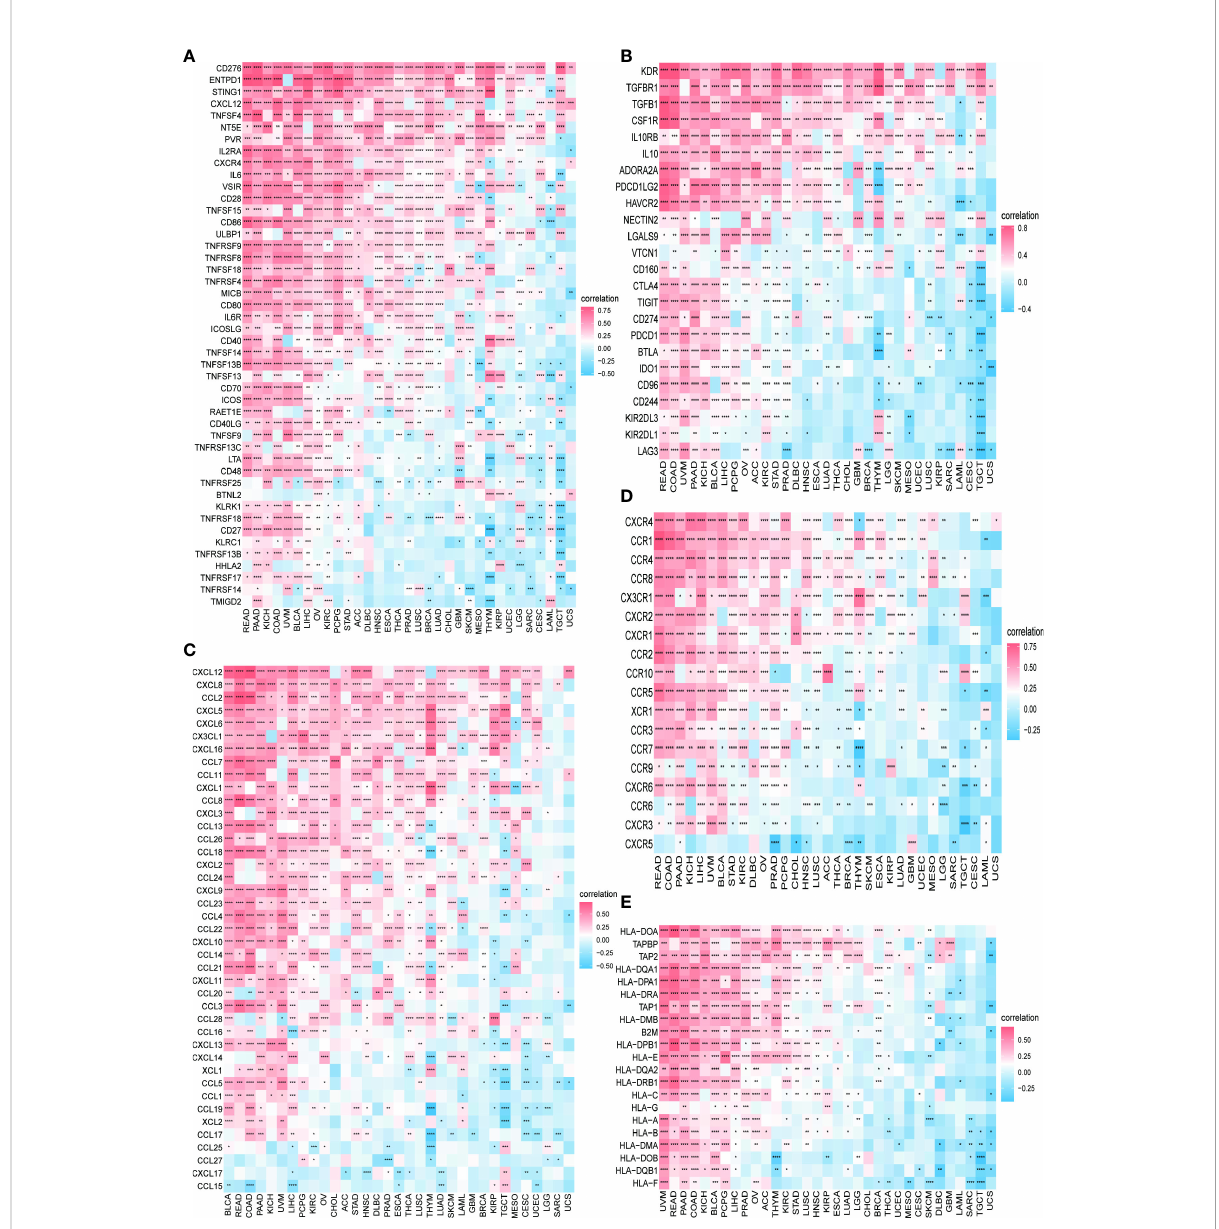
FIGURE 10 Relationship between PXDN expression and immune-associated genes. (A) Relationship between PXDN expression and the immuno-associated activating genes. (B) Relationship between PXDN expression and the immuno-associated suppressive genes. (C) Relationship between PXDN expression and the genes-related chemokine. (D) Relationship between PXDN expression and the genes-related chemokine receptor. (E) Relationship between PXDN expression and the MHC genes. Red and blue represent positive and negative correlations, respectively, while white represents p > 0.05. *p < 0.05, **p < 0.01, ***p < 0.001, ****p <